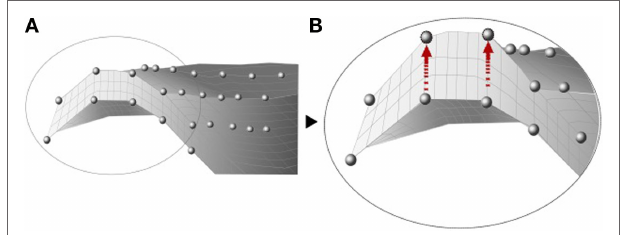
FIGURE 5 | Knee contact pressure (in MPa) of the statistical shape and alignment model (Rao et al., 2013) . Models presented correspond to the mean shape and the variation of the first two modes between (cid:6) 1 SD from the mean shape.